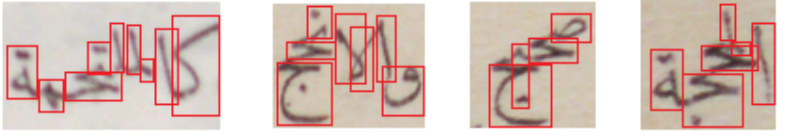
Figure 1. Some examples of Arabic words that contain ligatures with manually segmented